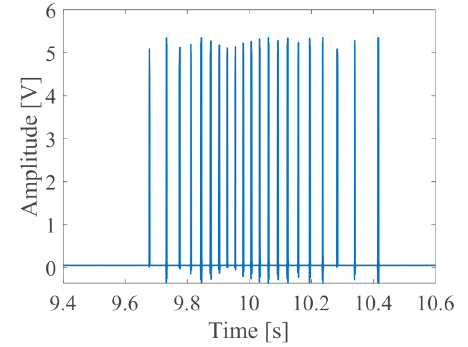
Figure 12. Pulse signal in inner race fault experiment.